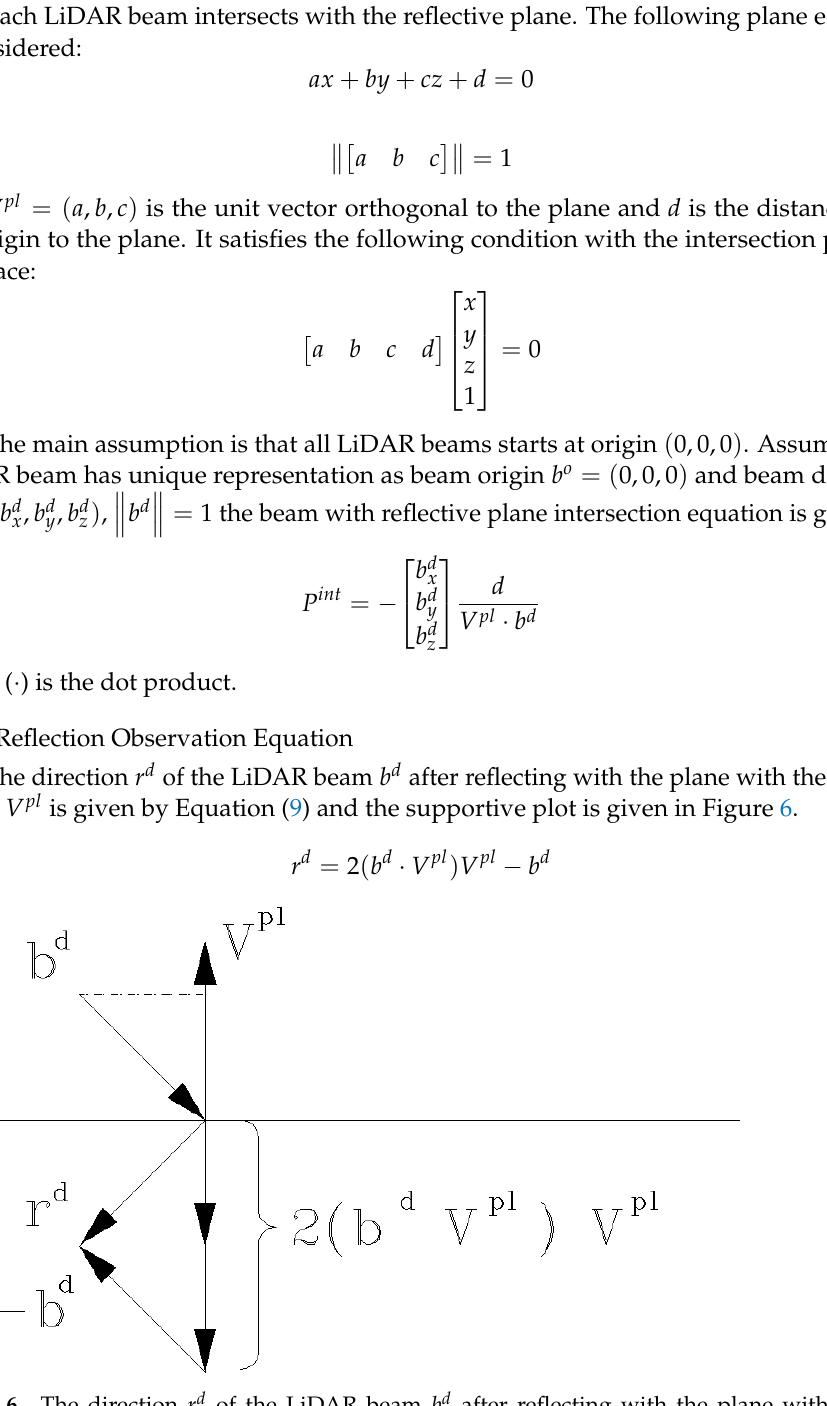
Figure 6. The direction r d of the LiDAR beam b d after reflecting with the plane with normal vector V pl